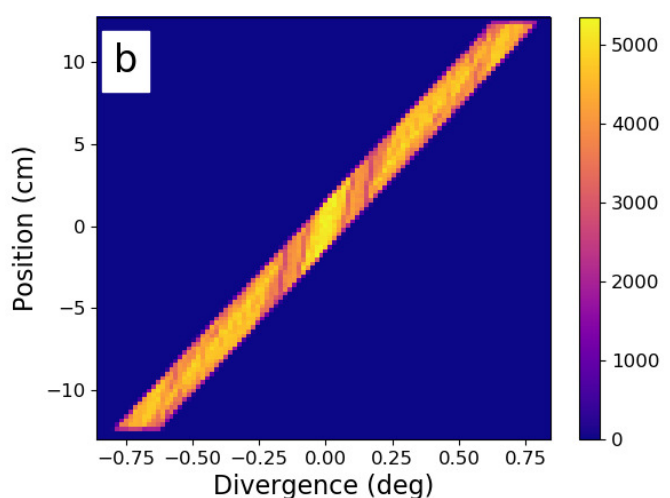
Figure 3. Redesign of a mature ESS instrument concept, and the improvements in phase space that were obtained. Here we see the horizontal phase space at the sample position. ( a ) the instrument baseline, with ∼ 7 years of development work. ( b ) the results of three days of redesign work using Sandman, providing double the performance and a e 1.8 M cost reduction